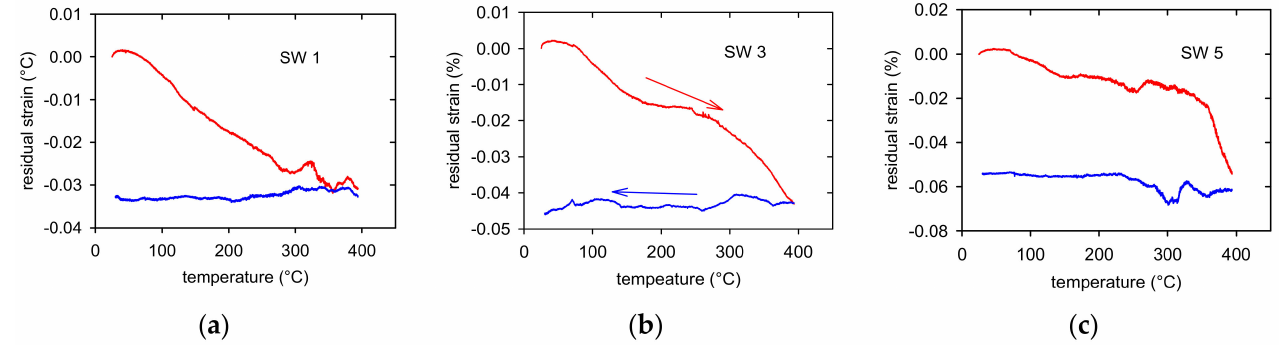
Figure 8. Residual strains estimated in ( a ) SW1, ( b ) SW3, and ( c ) SW5. Table 2. Permanent strains estimated after the first CTE measurement depending on the RSW counts. Swaging